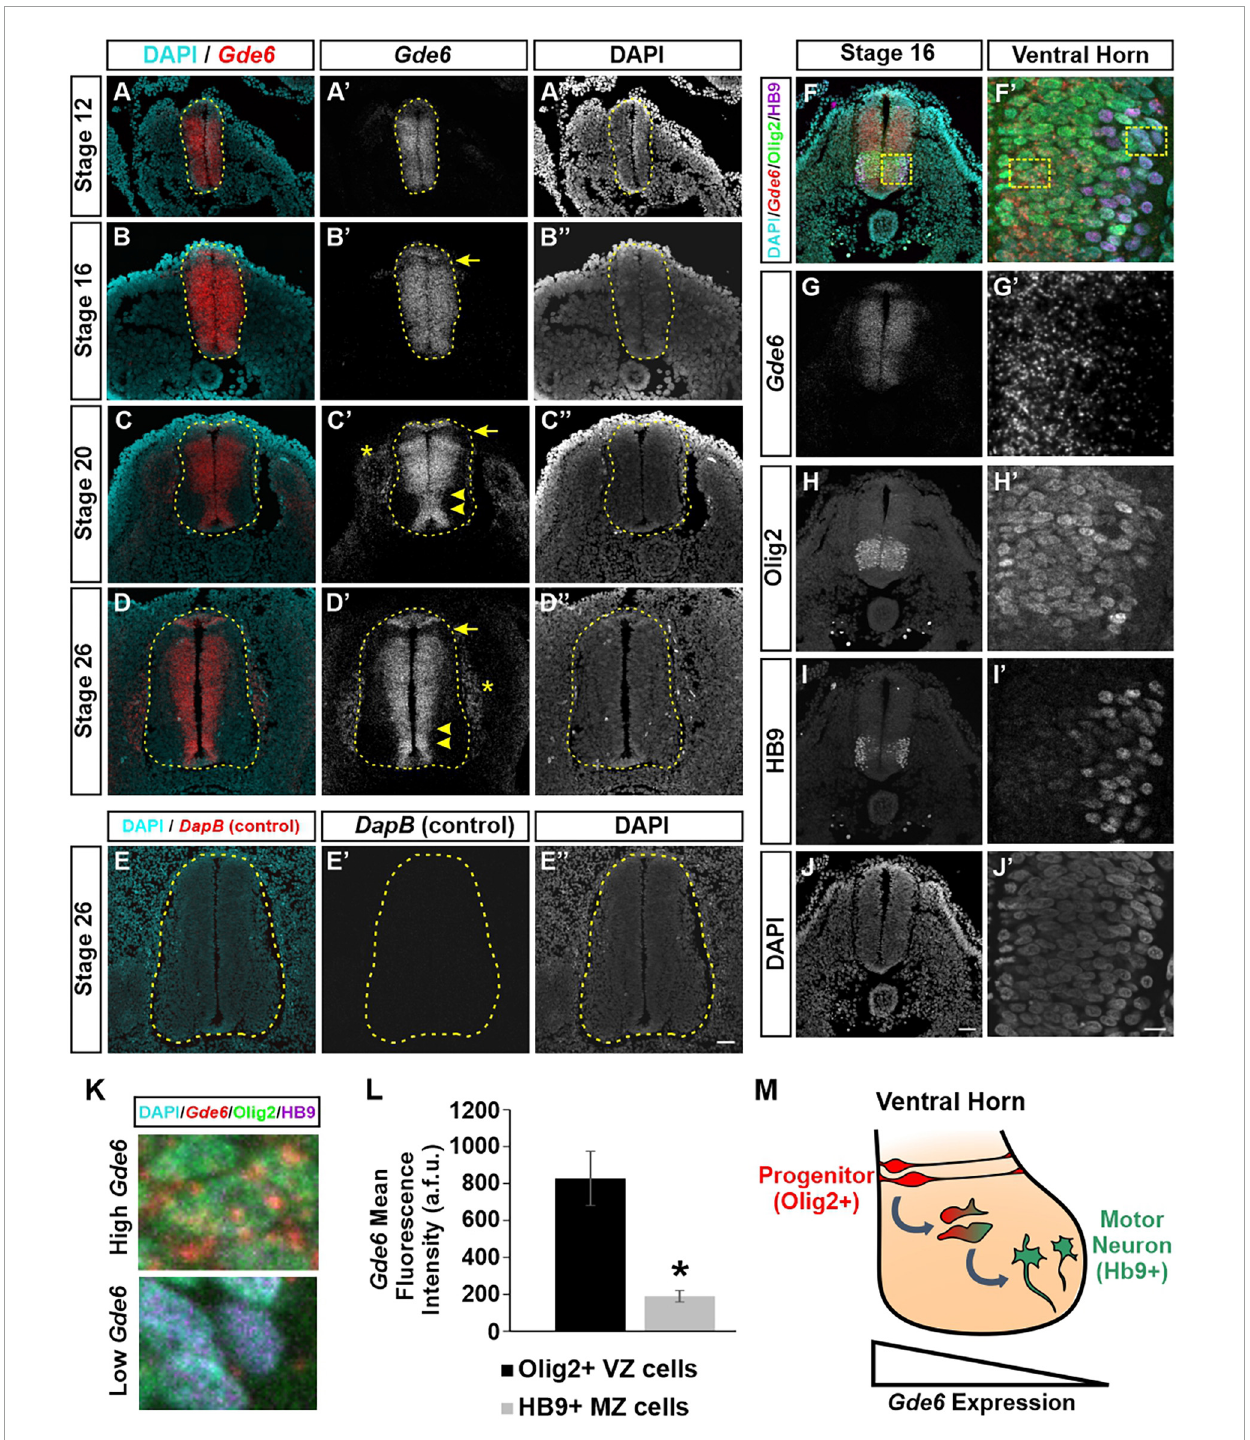
FIGURE1 Gde6 is expressed in the ventricular zone of the caudal neural tube. (A–D”) In situ hybridization using RNAscope shows robust Gde6 expression in ventricular zone progenitors during patterning (A,B) and neurogenic (C,D) phases. Dashed yellow lines outline the neural tube, arrowheads highlight medial expression, arrows indicate a dorsal patterning domain that lacks Gde6 , and asterisks denote expression in the periphery. (E) RNAscope negative control targeting bacterial DapB shows no signal. (F–J’) Combined RNAscope against Gde6 and immunohistochemistry for progenitor marker Olig2 and motor neuron marker HB9. Insets in the right column are magnified from the dashed square in panel (F) . (K) Insets from panel (F’) illustrating high Gde6- expressing Olig2 + cells and low Gde6 -expressing HB9 + cells. (L) Olig2 + cells have significantly higher Gde6 expression compared to HB9 + motor neurons. Signal is quantified in arbitrary fluorescence units (a.f.u.). Unpaired two-tailed t -test, * p = 0.013, n = 4. Error bars represent S.E.M. (M) Summary diagram illustrating the decreasing expression of Gde6 as cells transition from radial progenitors in the ventricular zone (VZ) to motor neurons in the marginal zone (MZ). Scale bar (A–E”) = 40 µ m. Scale bar (F–J) = 40 µ m. Scale bar (F’–J’) = 10 µ